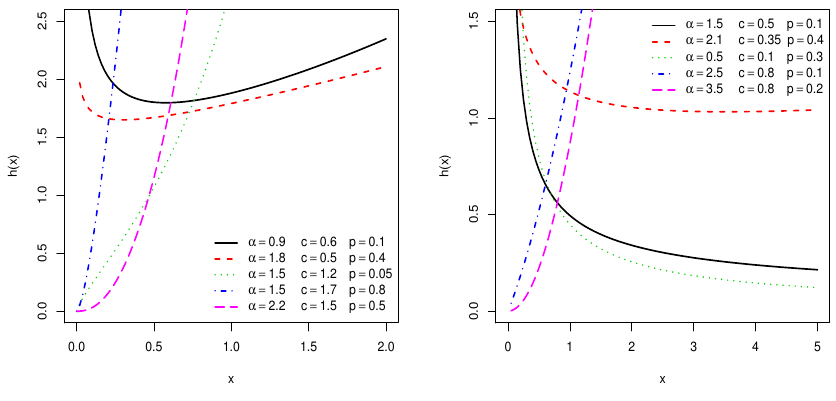
Figure 1. Plots of the OGWG pdf for certain parameter values (with β = 1 only).